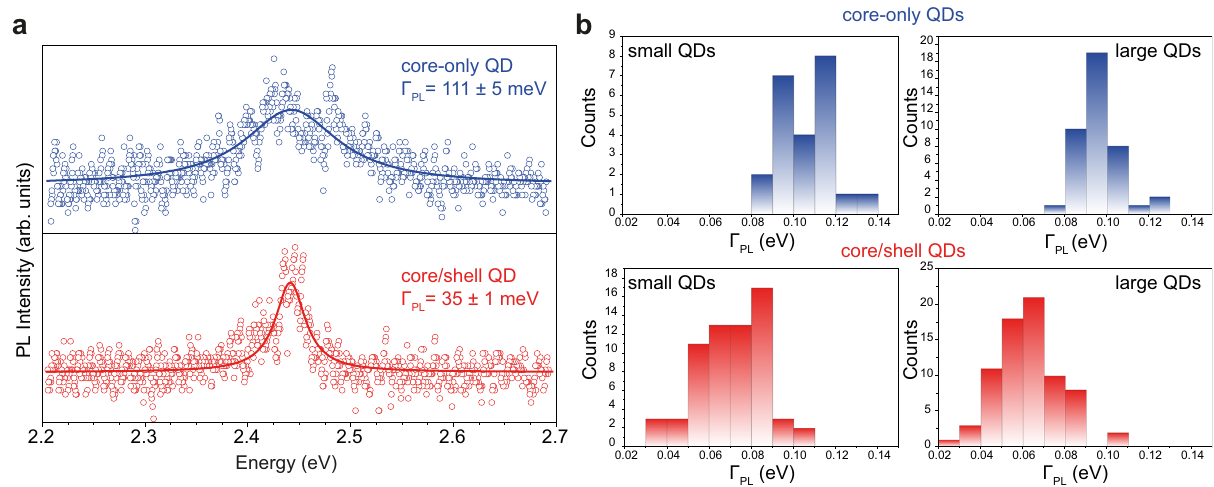
Fig. 4 Experimental single-QD emission line-broadening in core-only and core/shell QD heterostructures. a PL spectrum of a representative core-only QD (blue points) and of a core/shell QD (red points) exhibiting the record-low PL line broadening. Solid lines are best fi t to a Lorentzian function. b Histogram of emission line-broadening for several core-only and core/shell